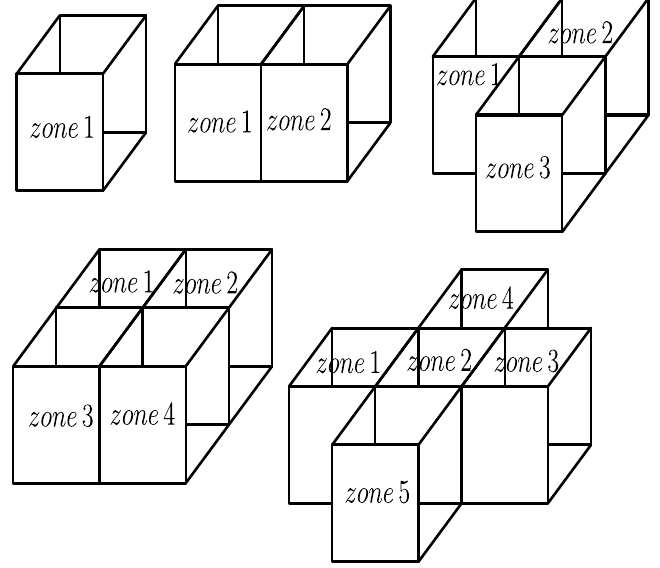
Figure 1. Multiple thermal zones located next to each